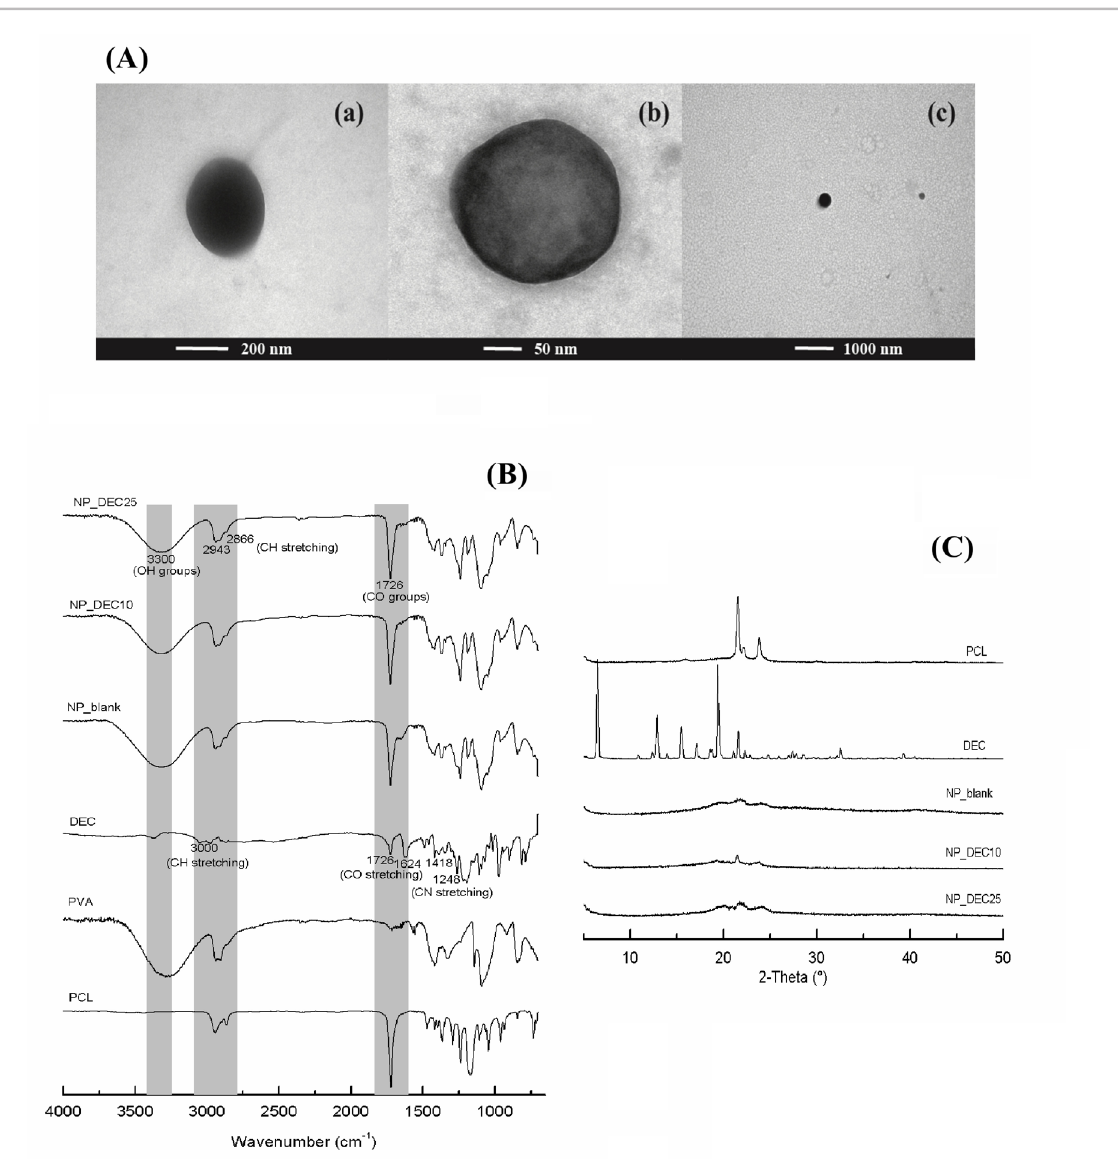
FIGURE 1 - (A) TEM of (a) NP_blank, (b) NP_DEC10, and (c) NP_DEC25. (B) ATR FT-IR spectra of the raw materials and nanoparticles produced. (C) XRD of the raw materials and nanoparticles produced. TEM, transmission electron